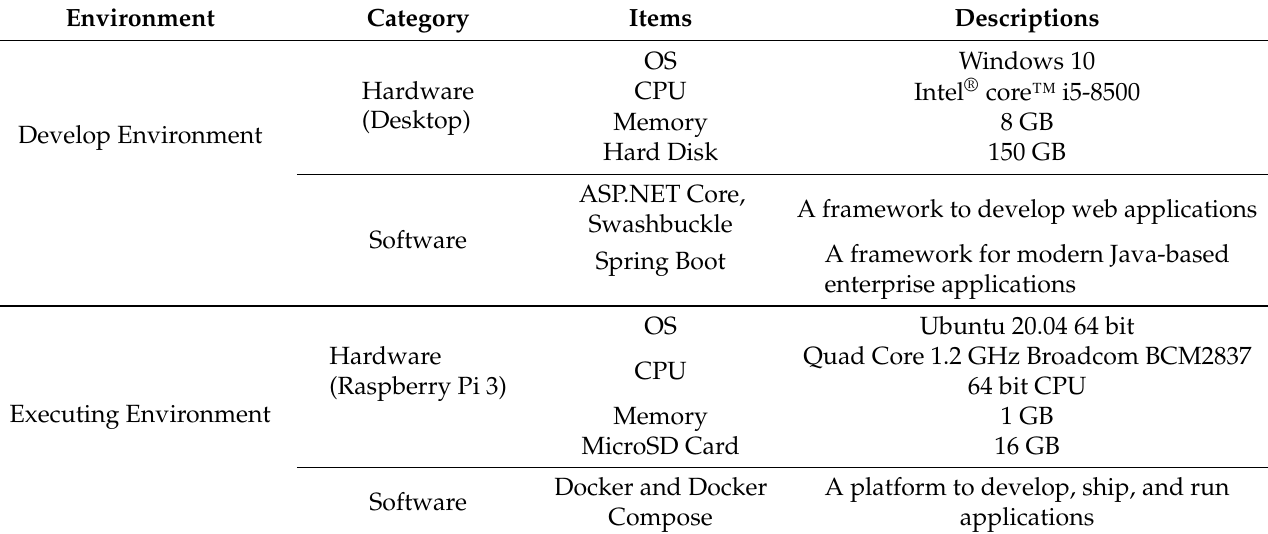
Table 7. Develop and Executing Specifications of Intelligent Edge Computing Platform